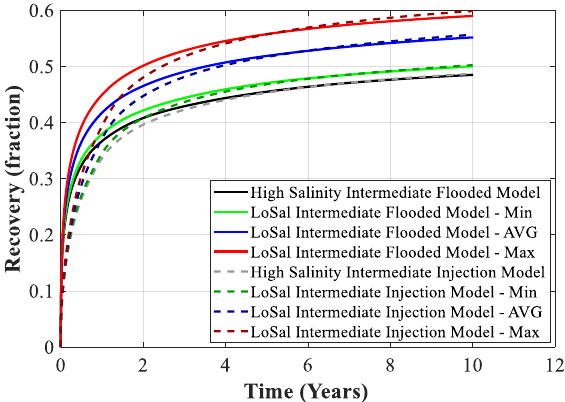
Figure 12. Comparison of the simulation results between the imbibition case (solid line) and injection case (dashed line) of the intermediate scale model. Faster oil recovery in the imbibition case was observed in the early time while higher ultimate recoveries were obtained by the injection case.